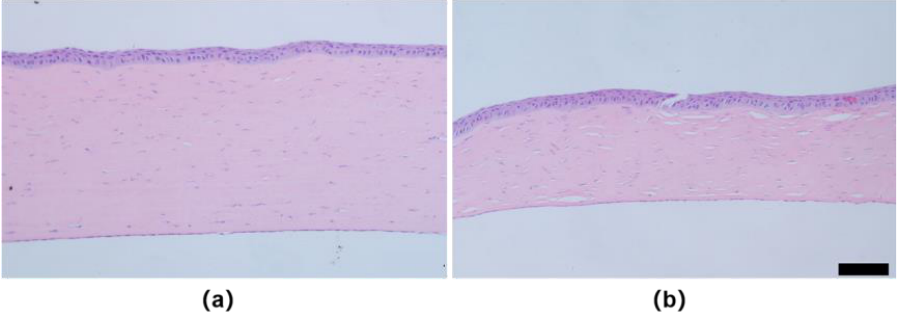
Figure 9. The H&E staining corneal sections of rabbits at 8 weeks. ( a ) normal cornea; ( b ) ectatic cornea (The scale bar is 100 μm).